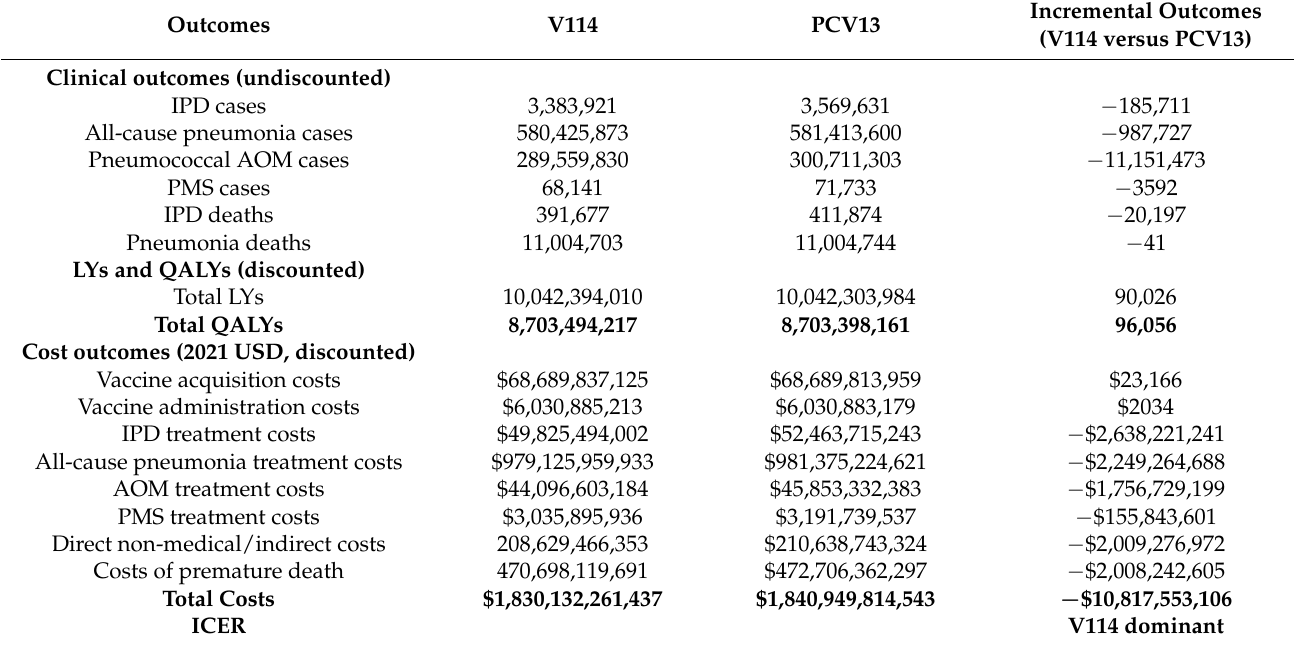
Table 5. Base-case